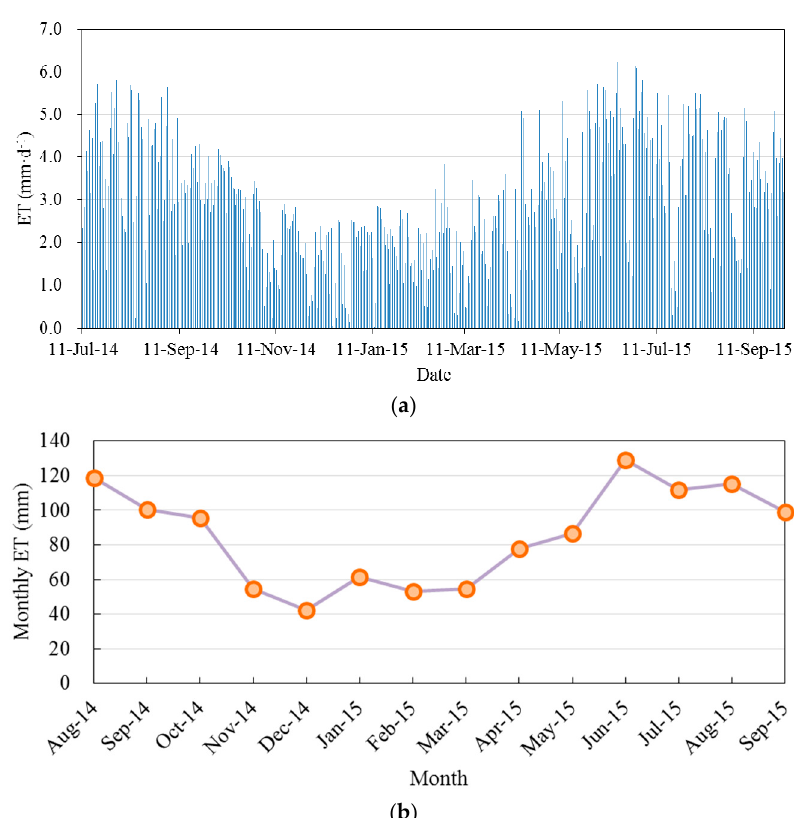
Figure 3. Daily ( a ) and monthly ( b ) average ET of the urban lawn from 11 July 2014 to 30 September 2015. Data were measured using the Bowen ratio tower.